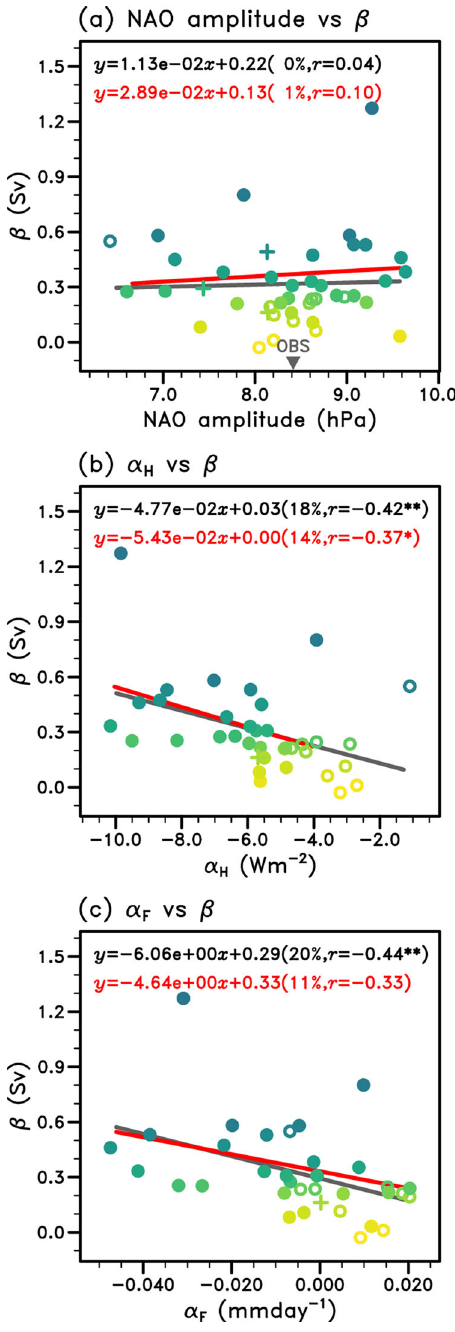
Fig. 4 Role of the NAO forcing in β diversity. a Scatterplot of the amplitude (unit: hPa; see Methods for the de fi nition) of decadal NAO forcing and β (unit: Sv) with color code for individual models following that of Fig. 1a. b , c : as in ( a ), but for α H (unit: W m − 2 ) and α F (unit: mm day − 1 ) on the x -axis. α H and α F are used as a measure of the NAO ef fi ciency to induce surface heat and freshwater fl ux at decadal timescale, respectively. The notation of lines and equations follows that of Fig. 1b. The qualitative results are insensitive to the window length. Among 42 CMIP6 models, 36 models provided all variables required for ( a ) and ( b ) (heat fl ux, SLP, and oceanic streamfunction) except CMCC-ESM2, CMCC-CM2-SR5, INM-CM4-8, INM-CM5-0, IPSL-CM6A-LR, and MIROC-ES2L. For ( c ) where fresh- water fl ux is required, 32 models were used except CNRM-CM6-1, E3SM-1-1-ECA, FGOALS-g3, and MIROC6, and MIROC-ES2L. Asterisk symbols ‘ * ’ and ‘ ** ’ indicate statistically signi fi cant values at the 90% and 95% con fi dence levels, respectively. npj Climate and Atmospheric Science (2023)